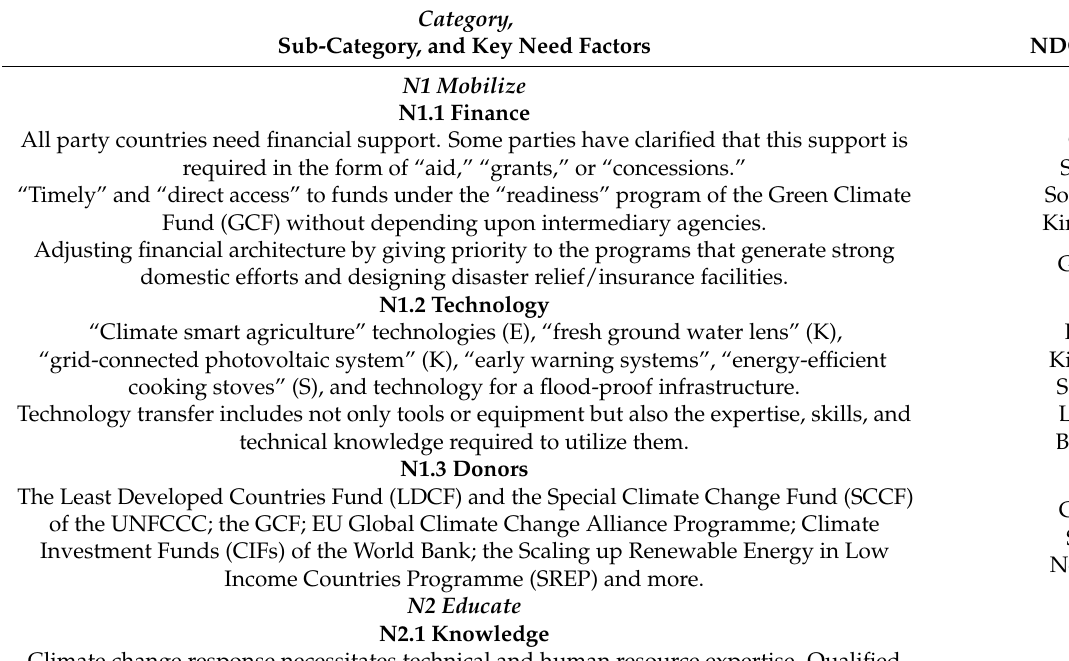
Table 3. A conceptual framework of climate action